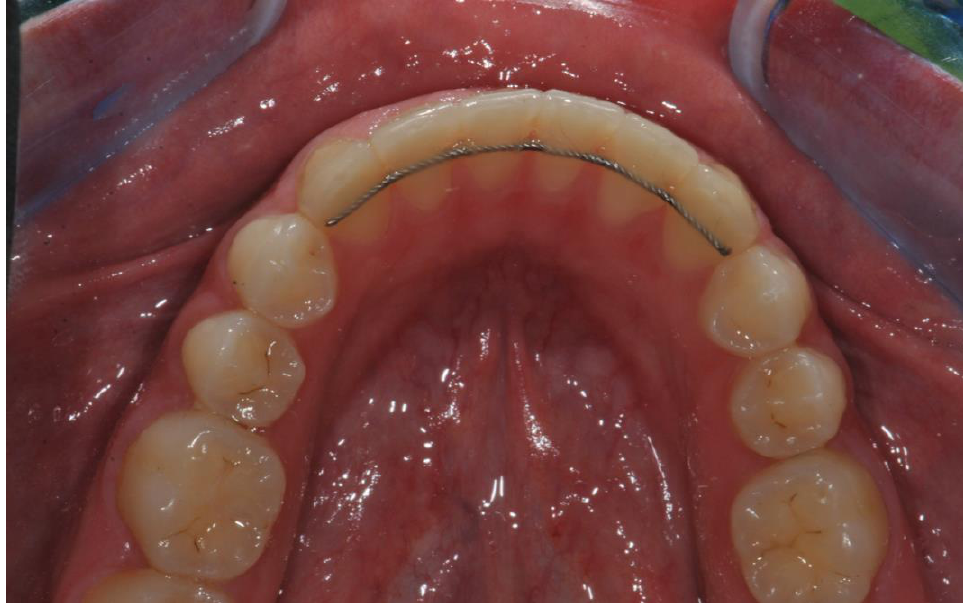
Figure 1. Orthodontic fixed retainer immediately after positioning.